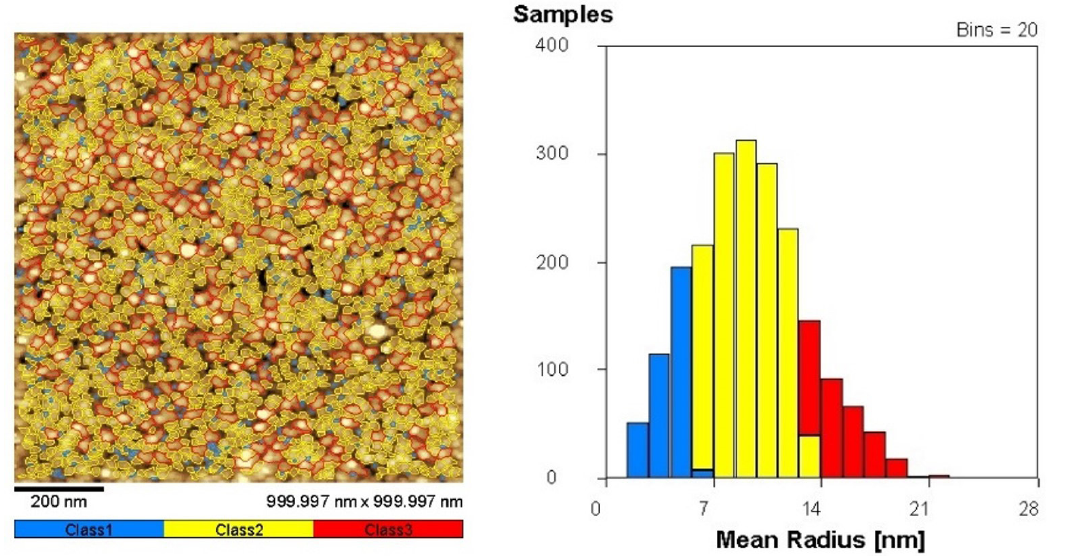
deposited onto BL (0 V) and the mean grain radius distribution. 2